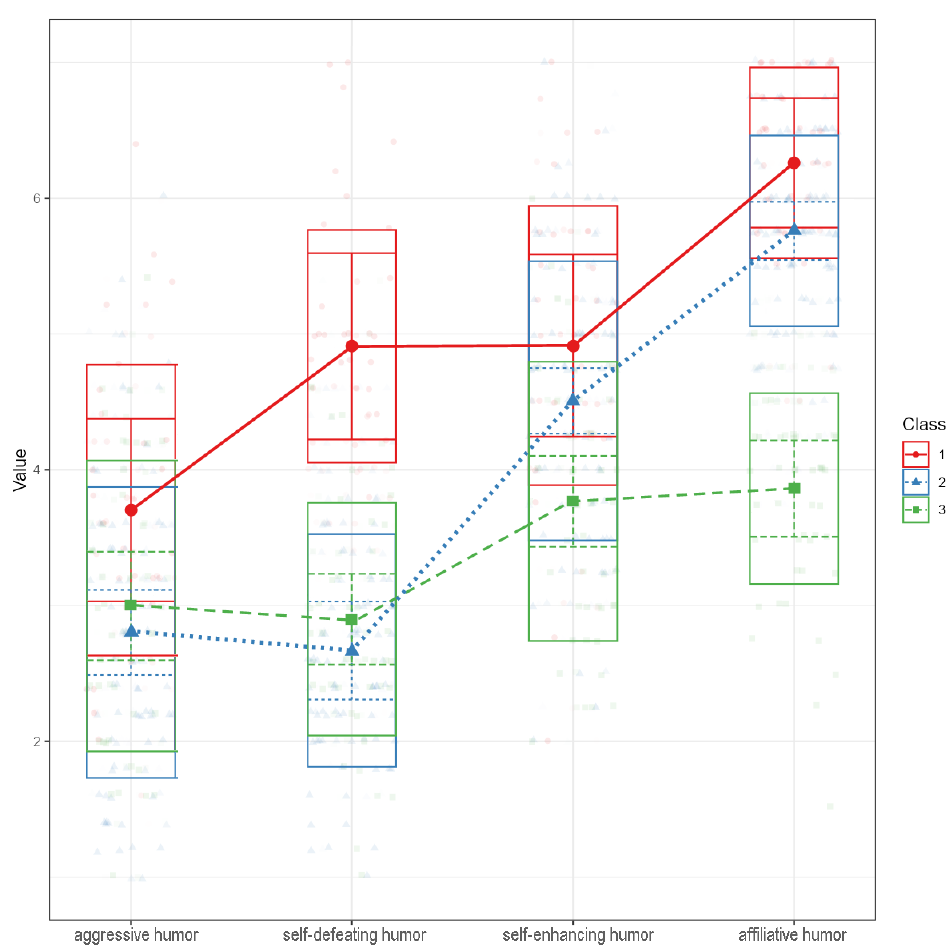
Figure 6. Latent profile plot of the three-class solution of different humor style uses. Note. Produced with Jamovi [54].